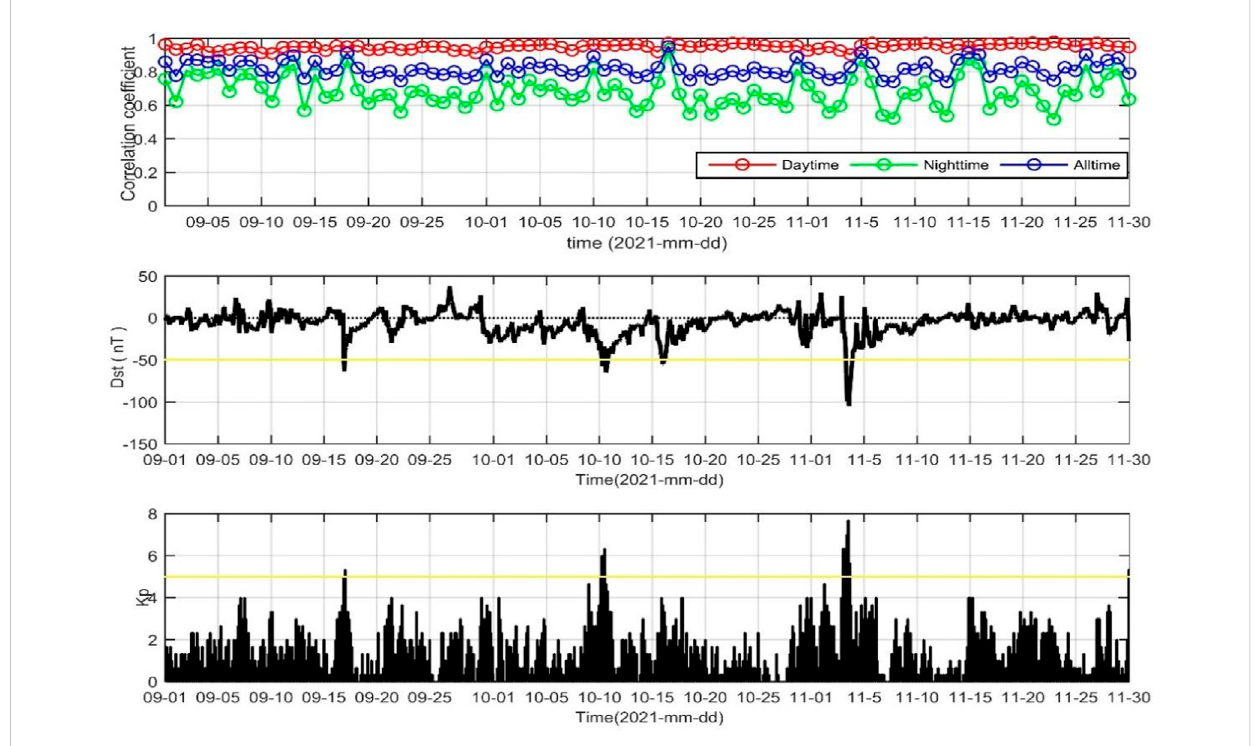
FIGURE 7 The variations of correlation coef fi cient and geomagnetic index Dst, Kp from 1 September to 30 November